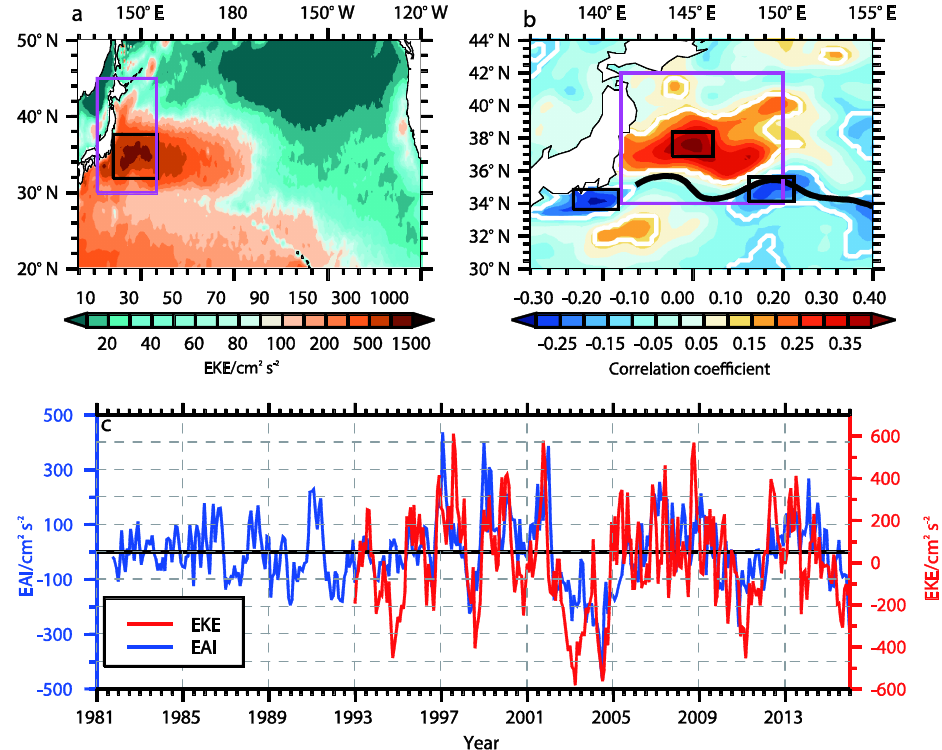
Figure 1. ( a ) Climatological distribution of the eddy kinetic energy (EKE) over the North Pacific. The purple box indicates the domain of Figure 1b (30°–44° N, 136°–155° E). The black box denotes the Kuroshio Extension (KE) region (32°–38° N, 142°–155° E). ( b ) Correlations of the sea surface temperature (SST) anomalies onto the normalized EKE time series averaged over the KE region. The white contours indicate the regions exceeding the 95% confidence level. The purple box indicates the Kuroshio–Oyashio confluence region (KOCR) (34°–42° N, 141°–150° E). The thick black line represents the mean KE jet axis, which is defined as the 110-cm SSH contour. The three black boxes denote the regions used to define the new eddy activity index (EAI) (see text for details). ( c ) Time series of the EAI (blue line) and the EKE (red line) of KE.